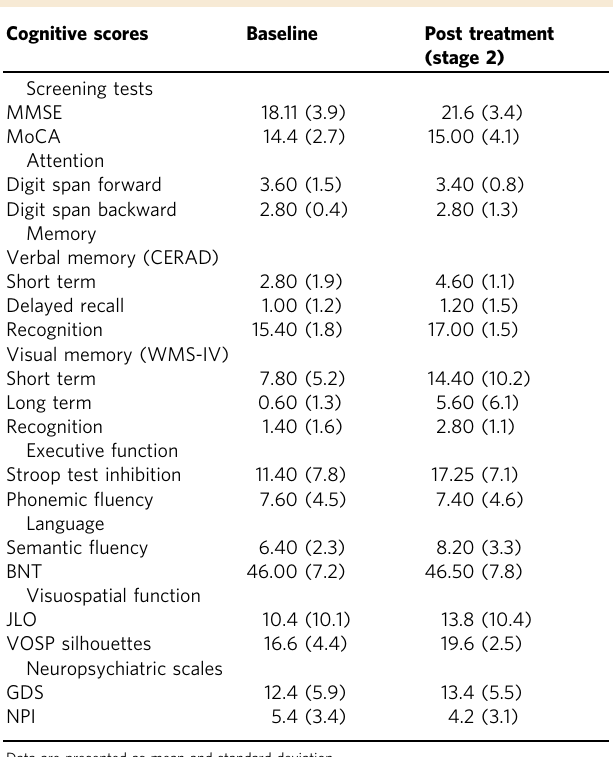
Table 2 Neuropsychological test scores.